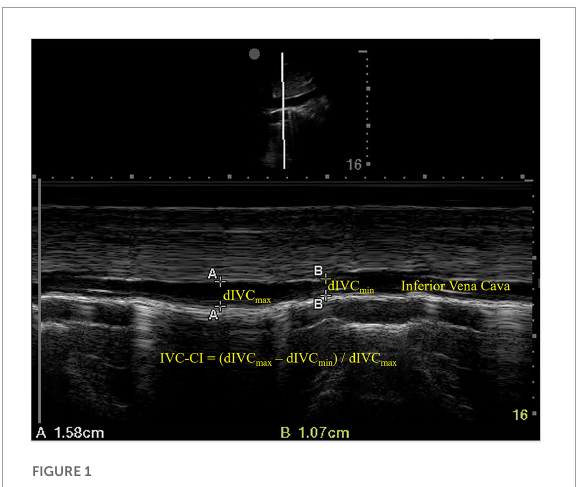
FIGURE1 Ultrasound measurements of the inferior vena cava. dIVC max , maximum inferior vena cava diameter; dIVC min , minimum inferior vena cava diameter; IVC-CI, collapsibility index of inferior vena cava.